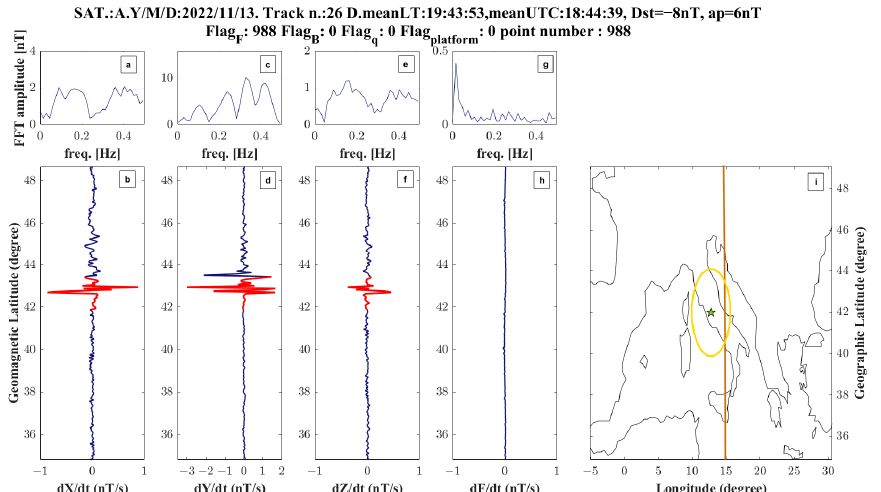
Figure 10. Swarm Alpha magnetic field analysis on 13 November 2022, track 26. The title reports the first satellite letter, date of acquisition, track number, mean local time and UT time, geomagnetic indexes, and the total number of original samples acquired with anomalous ESA Swarm data quality flags. Map ( i ) shows the projection of the satellite track in brown, and eventual anomalous flags are marked with red. The green star represents the epicentre of the M3.3 Guidonia 1 January 2023 earthquake, and the yellow circle is the Dobrovolsky of an earthquake of magnitude 4.1. The residuals of geomagnetic signals for X-North ( b ), Y-East ( d ), Z-Center ( f ) and F absolute scalar intensity ( h ) are represented with blue lines on the left, in correspondence with the map, and eventual anomalies inside the research area are marked with red lines. A spectrum of the signal made by Fast Fourier Transform (FFT) inside the minimum and maximum latitudes of the area is reported in ( a ), ( c ), ( e ) and ( g ) subfigures for X, Y, Z and F, respectively.